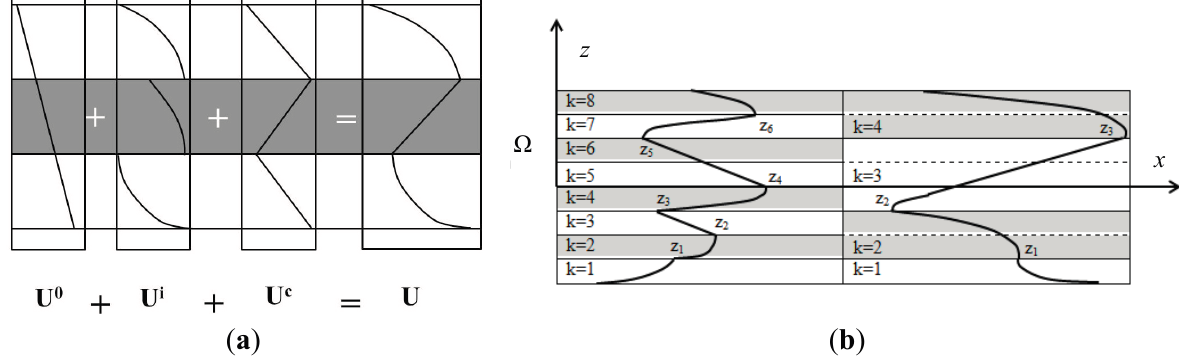
Figure 1. ( a ) Through-the thickness variation of displacement contributions; ( b ) geometry considered to enforce in-plane